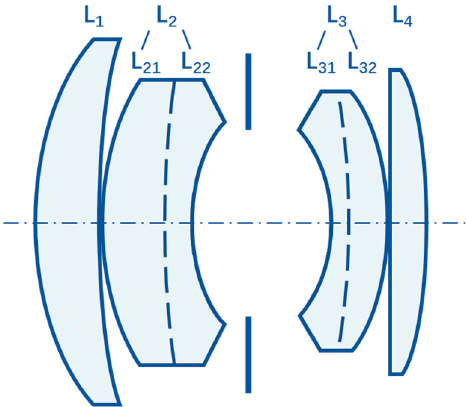
Figure 3. Double Gaussian structure [21].